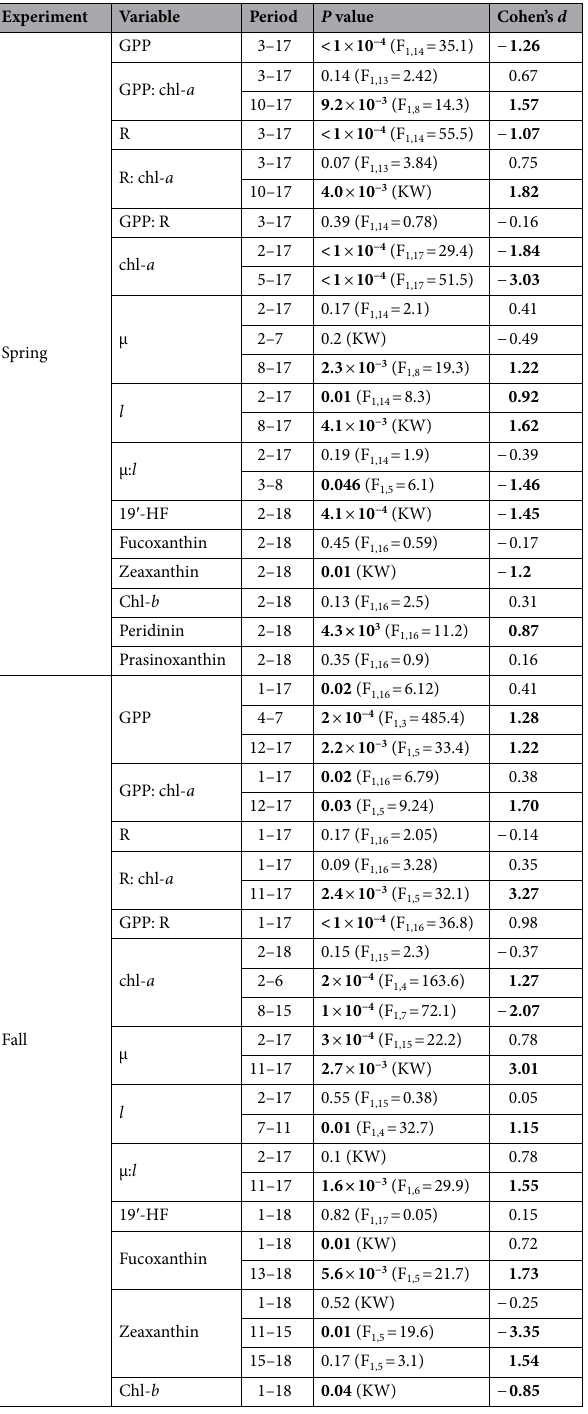
Table 2. Summary table of the p values and the F-values obtained with the RM-ANOVA (with treatment as fixed factor and time as random factor) comparing the chl- a fluorescence, µ, l , the µ: l ratio, and pigment concentrations in the warmed and in the control treatments over the entire spring and fall experiments or over specific periods defined after trends observed in the data. Associated Cohen’s d effect sizes are also indicated. When the assumptions for a parametric test were not met, despite transforming the data, a Kruskal–Wallis test was used instead and indicated by “KW”. P values lower than 0.05 were considered as significant and are indicated in bold in the table. Large and very large Cohen’ s d effect sizes were also displayed in bold (GPP: Gross Primary Production, chl- a : chlorophyll- a , R: Respiration, µ: growth rate, l : loss rate, 19 ′ -HF: 19 ′ -hexanoyloxyfucoxanthin, Chl- b : chlorophyll- b